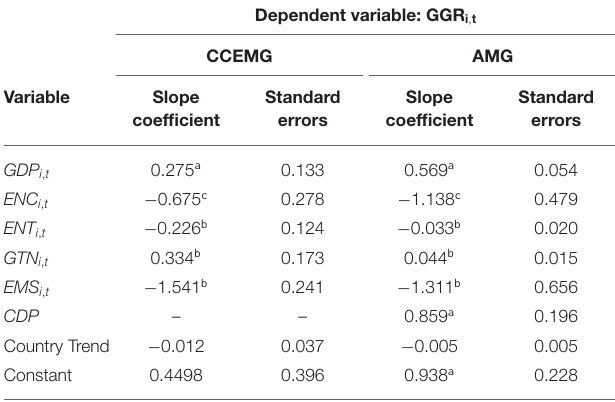
TABLE 9 | CCEMG and AMG